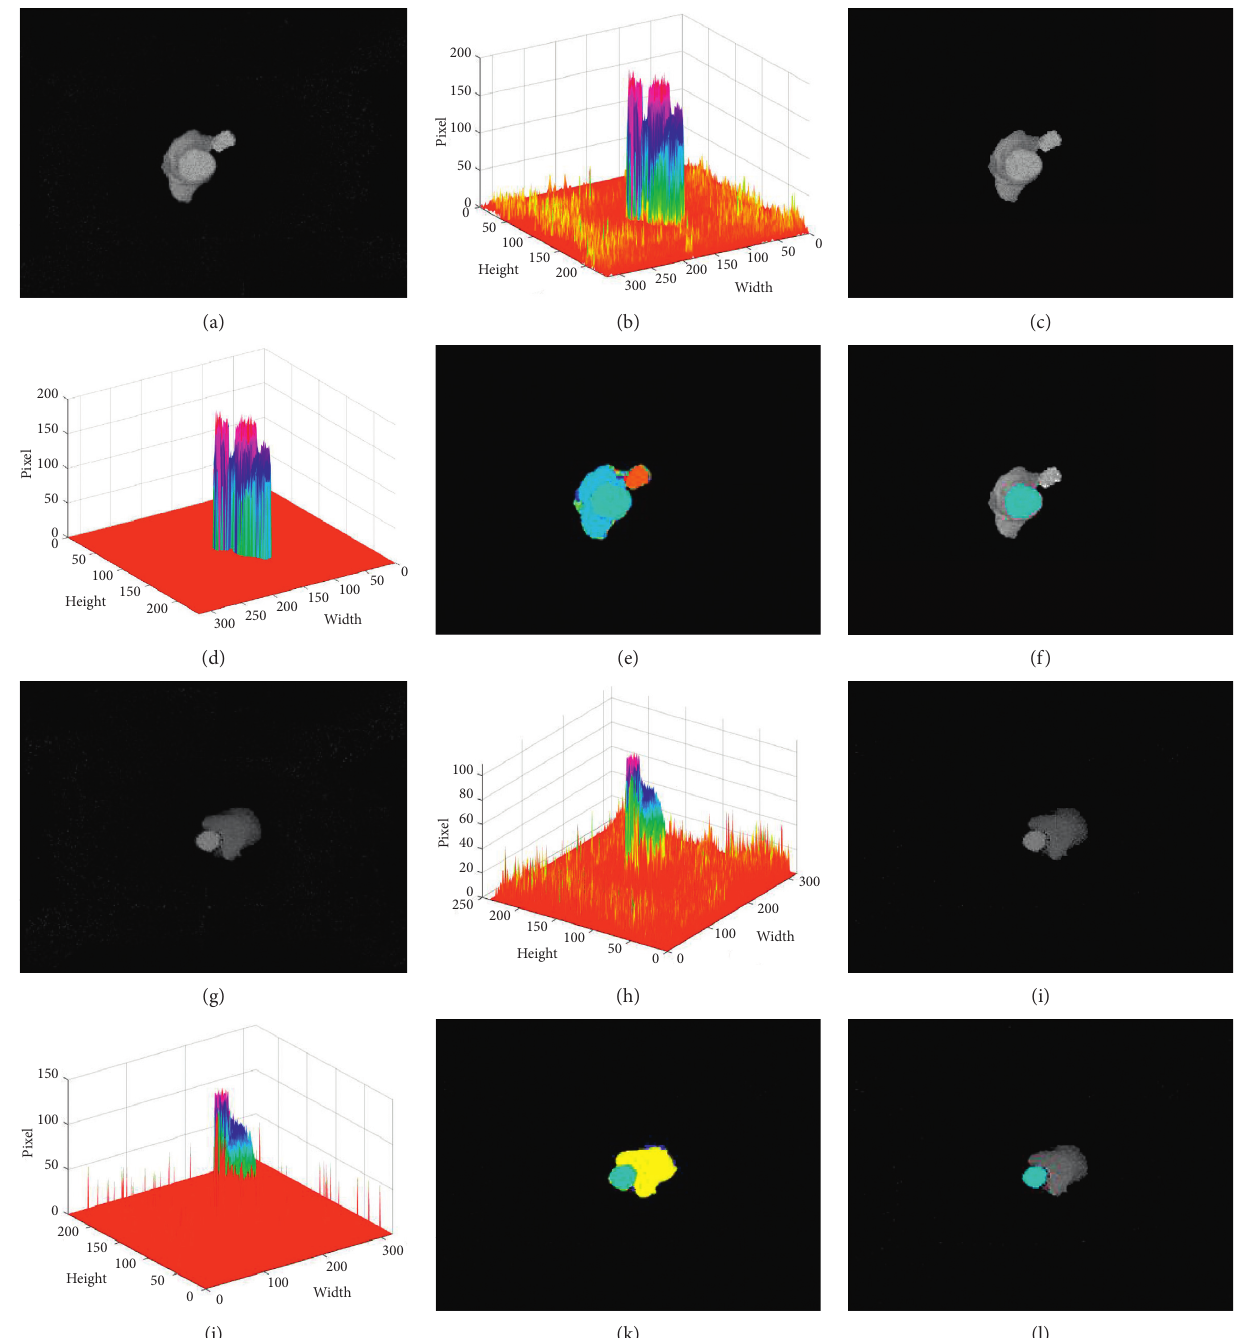
Figure 7: Experiments with the pedestrian in different states. (a) Original image with the pedestrian raising his left hand. (c) Image obtained by the PSO algorithm along with that in (a). (e, f) Images obtained by the MSER-based segmentation along with that in (c). (b, d) The 3D representation of images in (a, c), respectively. (g) Original image with the pedestrian who is kneeling. (i) Image obtained by the PSO algorithm along with that in (g). (k, l) Images obtained by the MSER-based segmentation along with those in (i). (h, j) The 3D representation of images in (g, i),